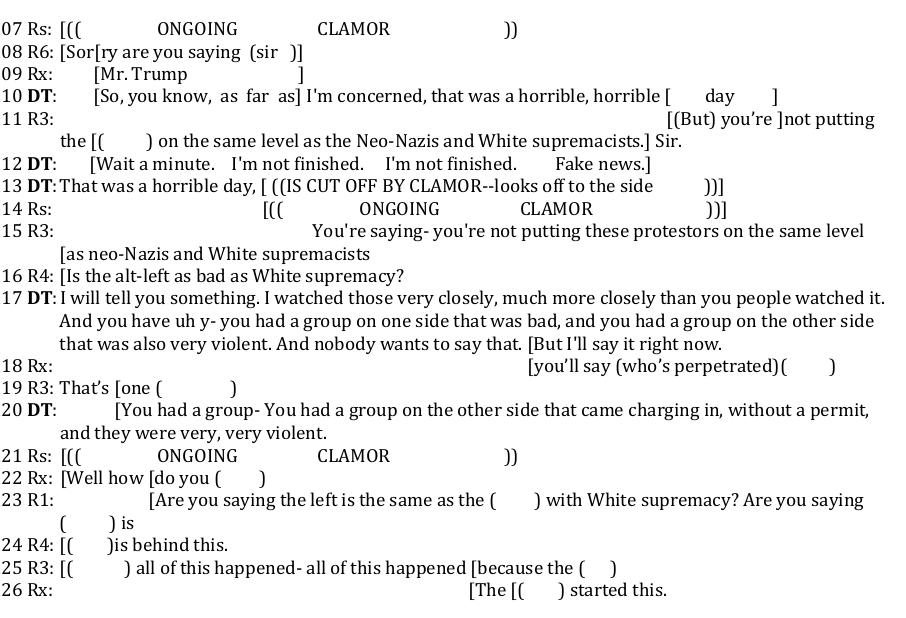
Figure 12. Transcript excerpt 107–126.